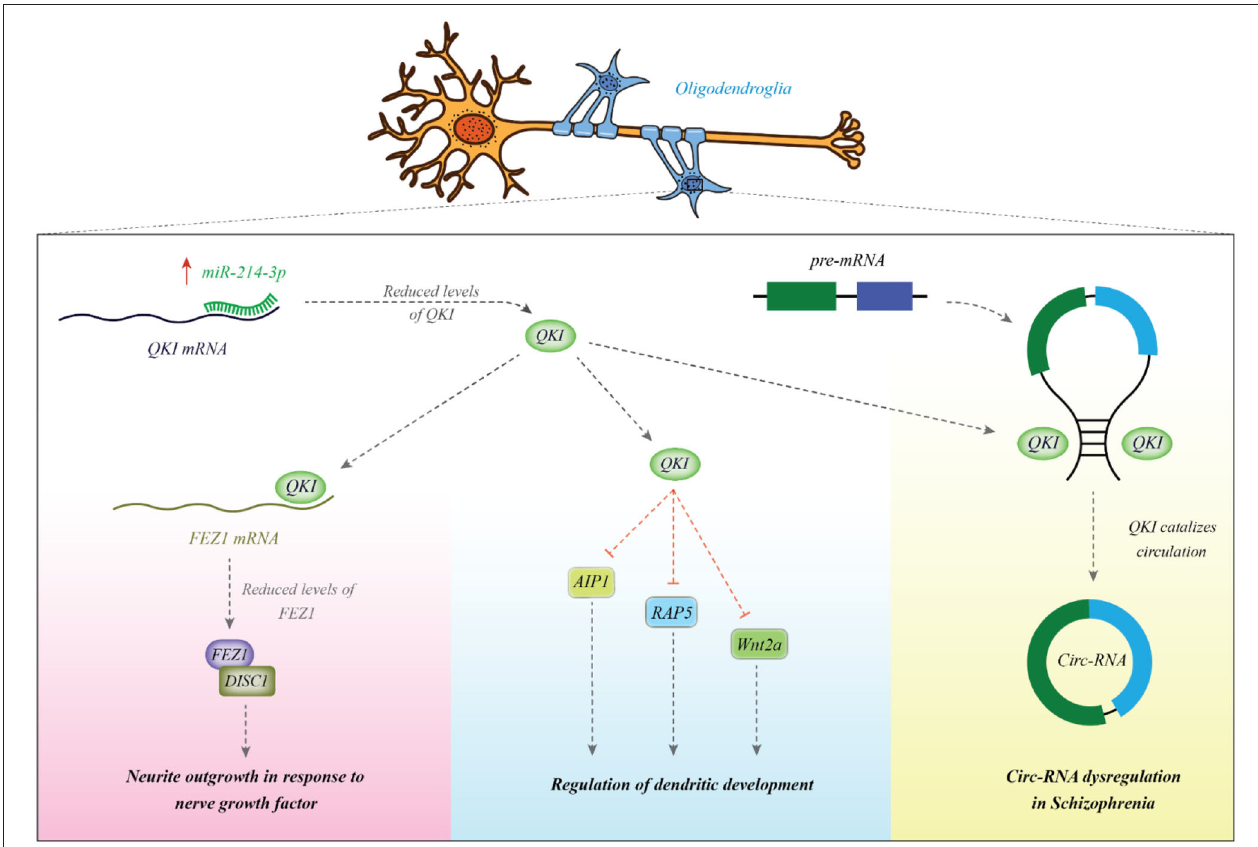
FIGURE 1 | miR-214 is overexpressed in patients with schizophrenia. This miRNA binds with the 3 ′ UTR of Qki transcript to reduce its expression. Qki is an RNA-binding protein which modulates stability of several mRNAs among them are AIP1, Wnt2a, and Rab5. These transcripts are involved in the dendritic development (39). Qki can also bind with FEZ1 mRNA to enhance its stability (41). FEZ1 binds with DISC1 and increases neurite outgrowth in response to NGF (42). Qki can bind with intronic regions and participate in the biogenesis of circRNAs (43). Abnormal expression of Qki might be associated with the observed dysregulation of cricRNAs in schizophrenia (